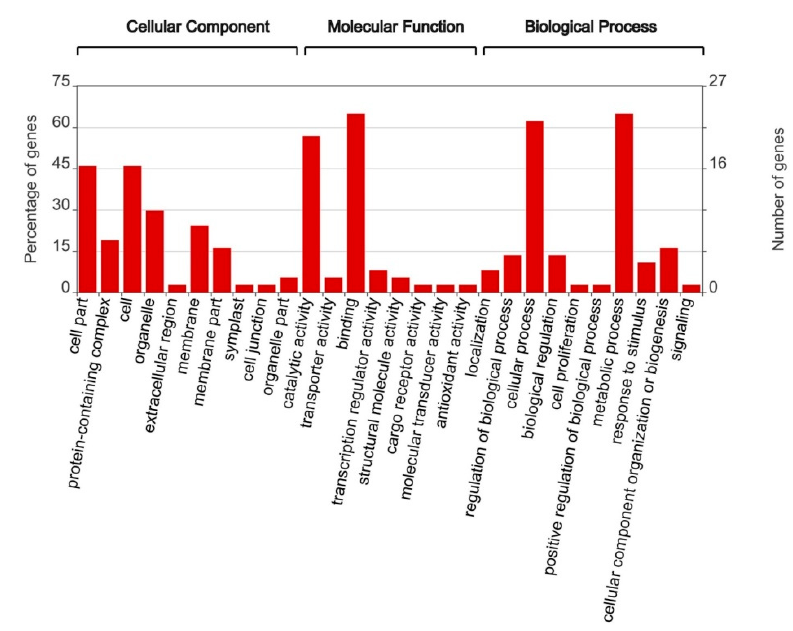
Figure 12. GO (Gene Ontology) annotation of genes in scaffolds with significant outlier SNPs.